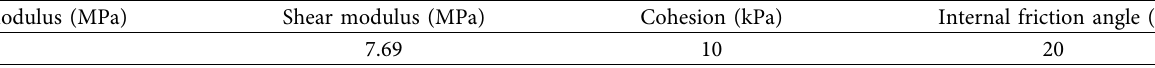
Table 5: Material parameters of soil in the numerical model.